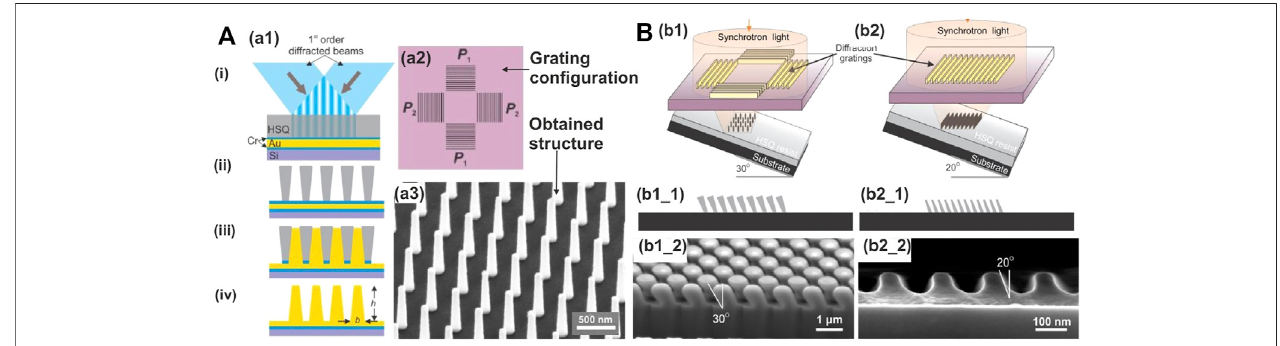
FIGURE 2 | (A) Scheme of the XIL technique (a1) basic principle 1) soft X-ray irradiation of HSQ resist on a silicon substrate with base plating. Only two of the four interferingbeamsareshown,2)nanostructuresinHSQresistafterdevelopment,3)CretchingandAuelectroplatingusingHSQasatemplateand,4) fi nalstructuresinAu after removing the resist (a2) four-grating con fi guration for coherent (P1 = P2) and incoherent (P1 ≈ P2) interference. (a3) Scanning-electron micrographs (45 ° tilt) of Au nanopillars with an aspect ratio of ~6. (B) Exposure scheme (b1, b1_1, b2, b2_1) and resulting oblique structures (b1_2) at 30 ° and (b2_2) 20 ° . Adapted from Mojarad et al. (2021) with permission of AIP